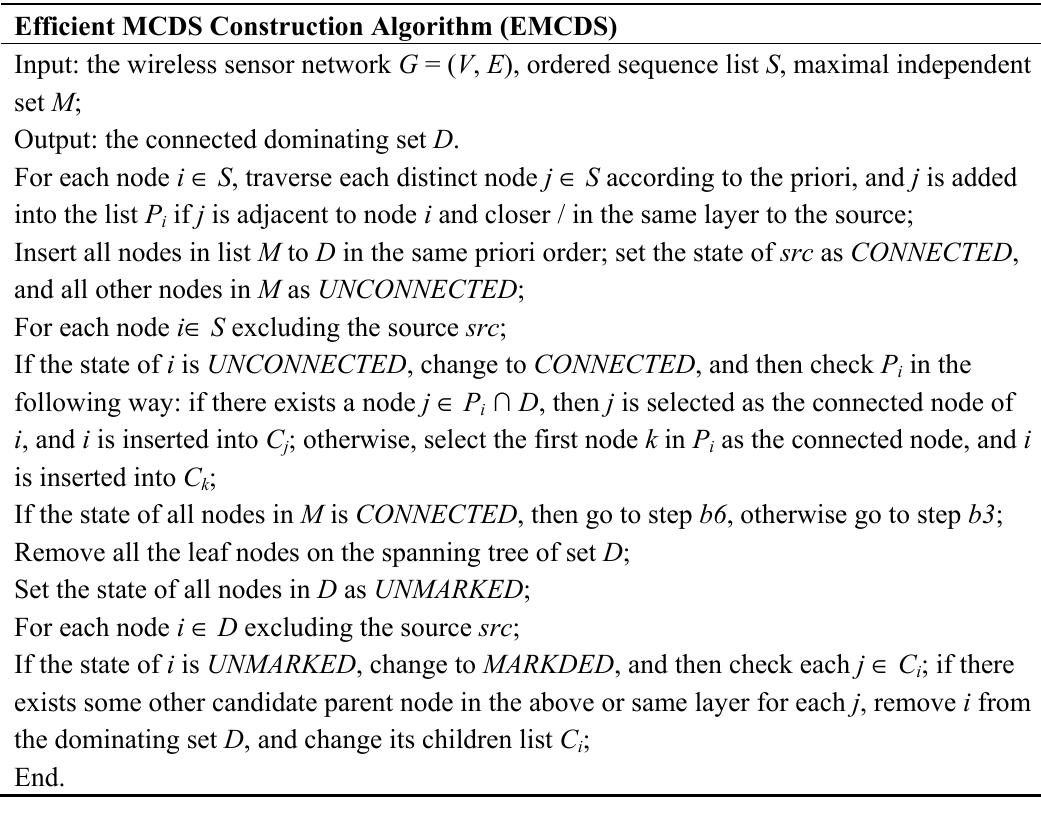
Algorithm 2. Efficient MCDS Construction Algorithm (EMCDS). Efficient MCDS Construction Algorithm